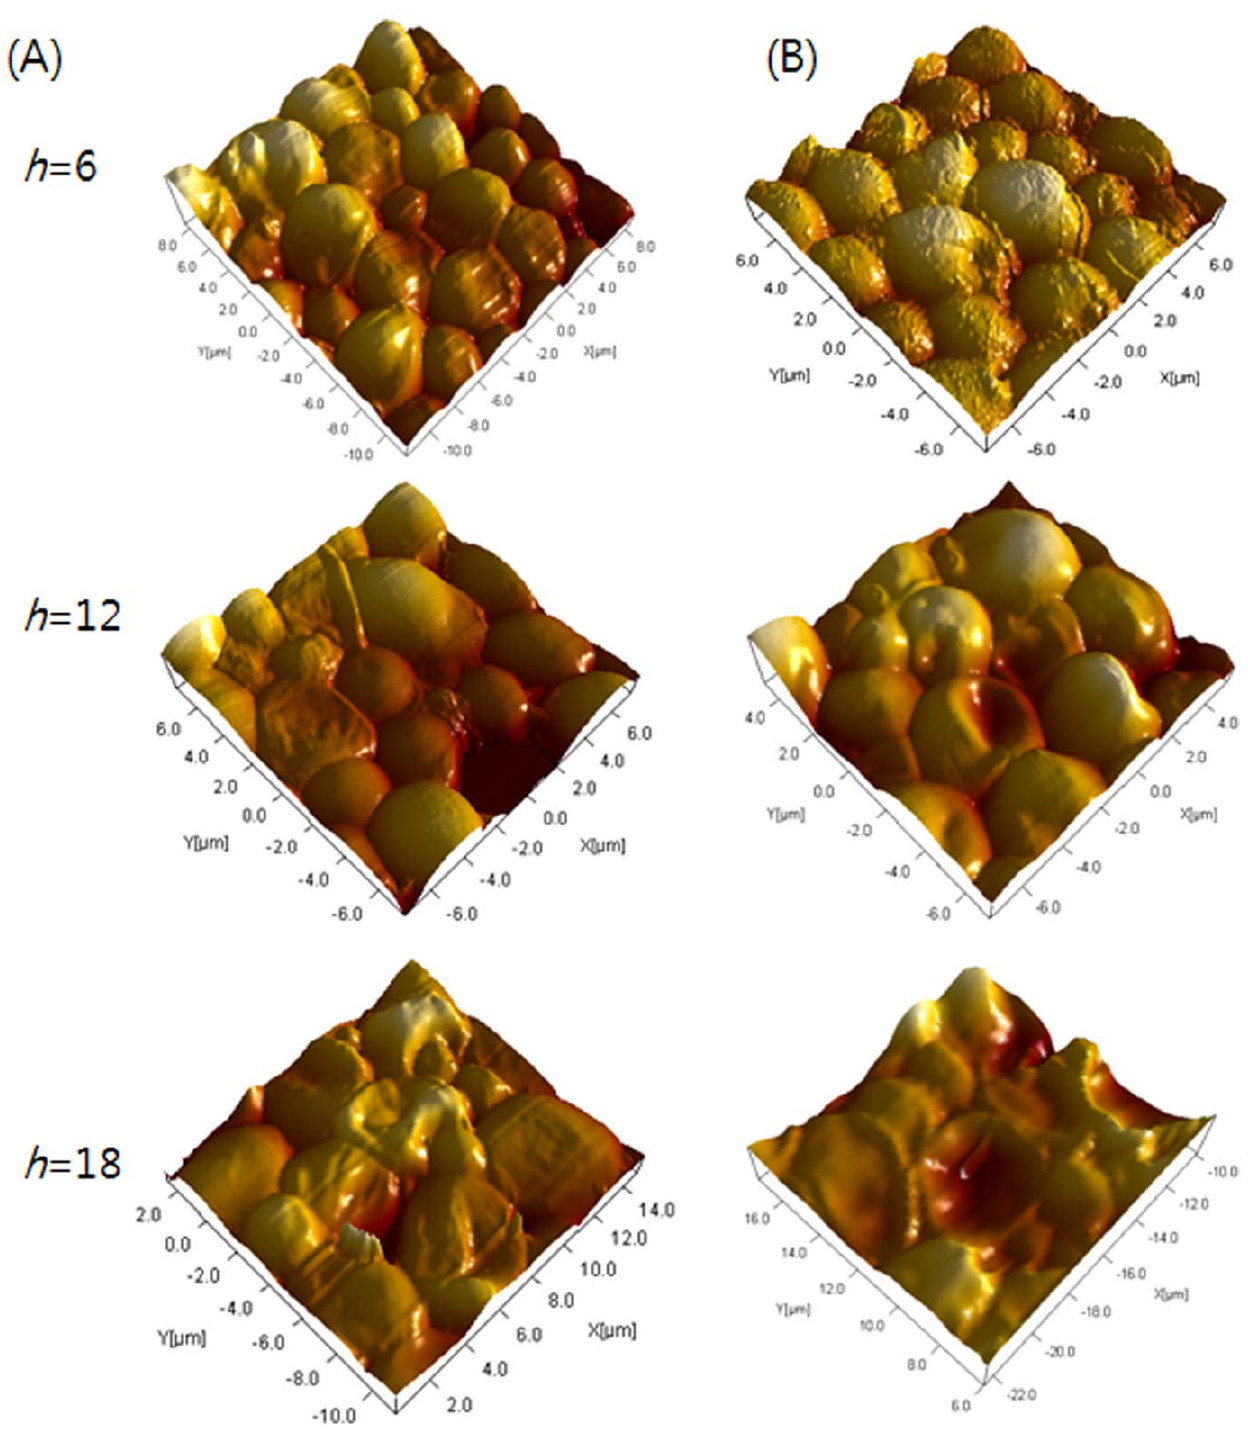
Figure 4. Three-dimensional AFM images. A and B correspond to three-dimensional images of Fig. 3(A) and (B), respectively. doi:10.1371/journal.pone.0028176.g004 be understood by the mechanism of action of the flucytosine. The flucytosine is a fluorinated pyrimidine analog which mainly acts on RNA and DNA. It shows antifungal activity by inhibiting RNA and fungal replication by DNA synthesis inhibition [14] and is metabolized into 5-fluorouracil. The damaged RNA and DNA prevent a normal metabolism, a protein synthesis, and are